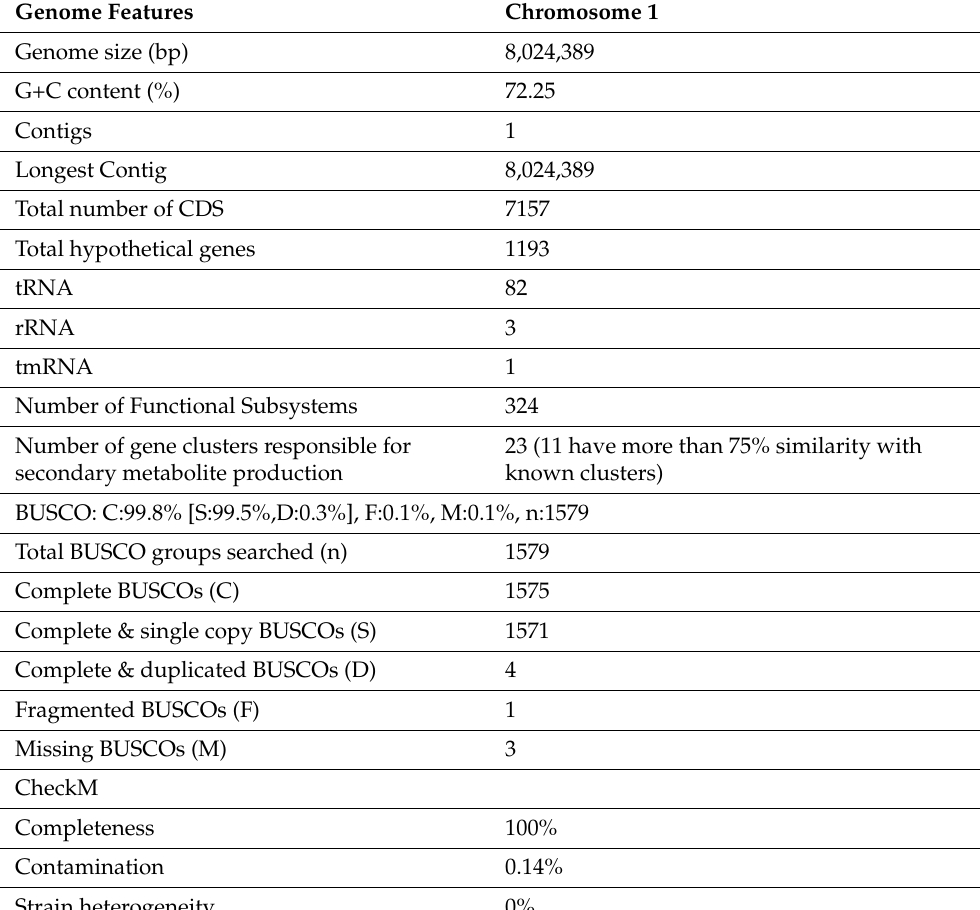
Table 2. Features of Streptomyces sp. strain BSE6.1